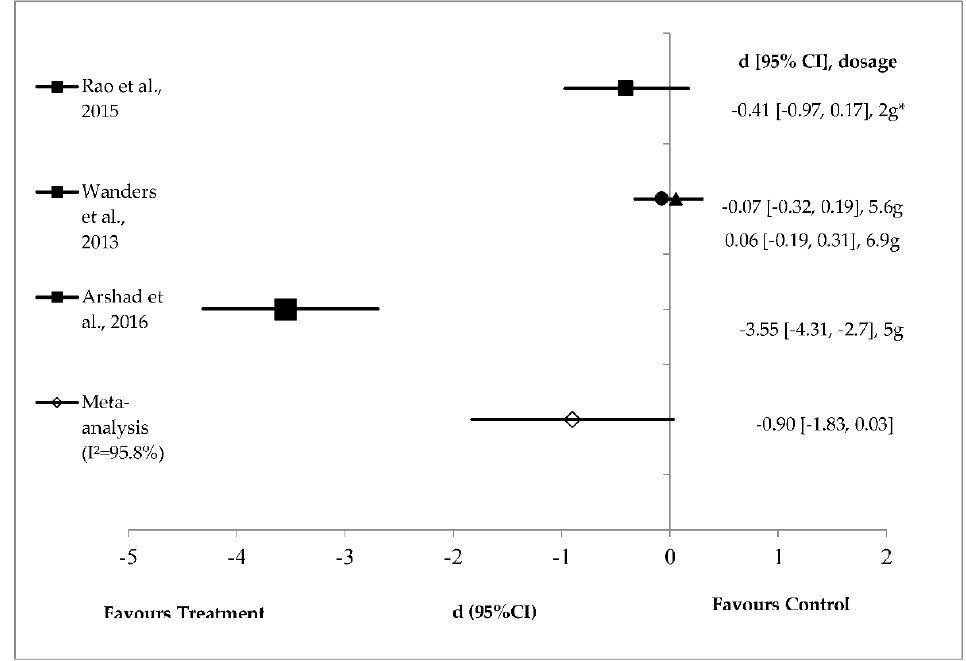
Figure 4. Effects of guar gum on energy intake reduction (random effects model). The axis lines on ± 0.2, ± 0.5 and ± 0.8 represent small, medium and large effect sizes respectively. A negative value of summary effect size suggests that the guar gum supplementation decreases energy intake compared to control. *2 g of partially hydrolysed guar gum (PHGG); ● : 5.6 g of guar gum; ▲ : 6.9 g of guar gum.